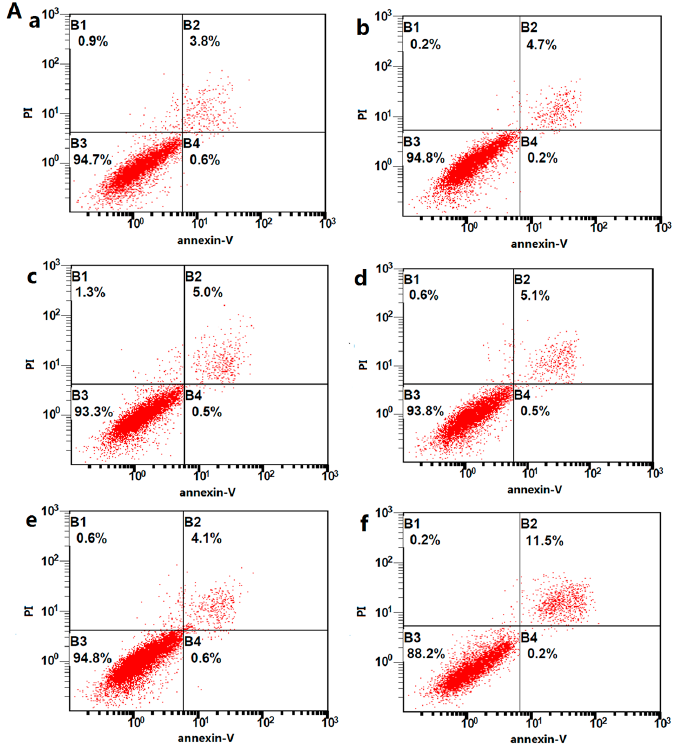
Figure 5. Cont. Figure 5. Cont